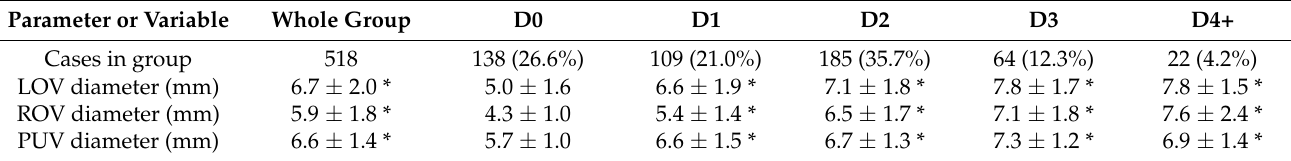
The values shown in the table represent mean ±SD, as well asthe number (percent) of cases within the respective group. Abbreviations: SD: standard deviation, LOV: left ovarian vein, ROV: right ovarian vein, PUV: parauterine vein. The values marked with asterisks (*) were statistically significantly different compared to the corresponding values in the D0 group.